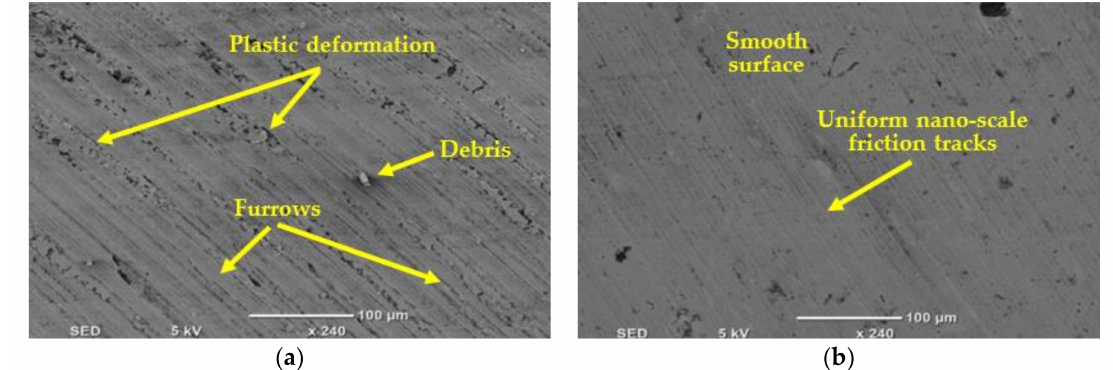
Figure 13. SEM of machined surface under different cooling conditions ( a )dry and ( b ) MQL + Al 2 O 3 nanoparticles at cutting speed = 50 m/min and feed rate = 75 mm/min.